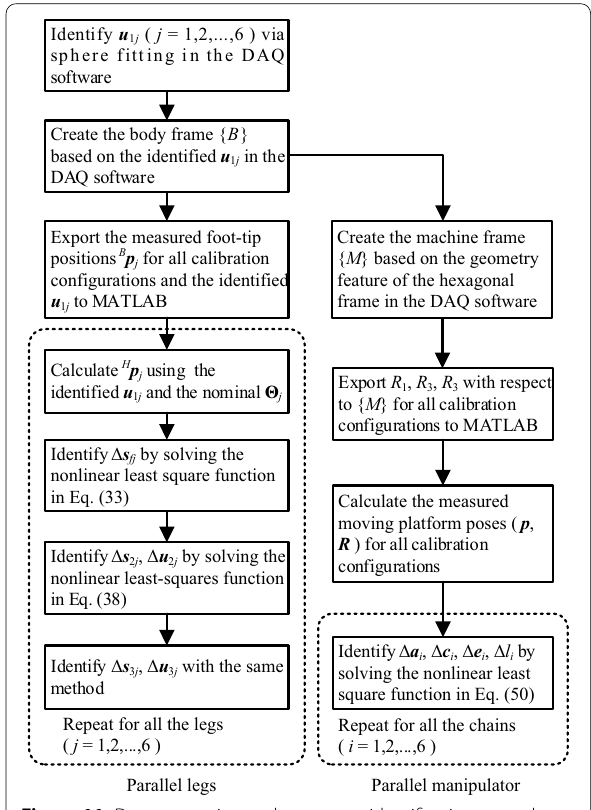
Figure 11 Data processing and parameter identification